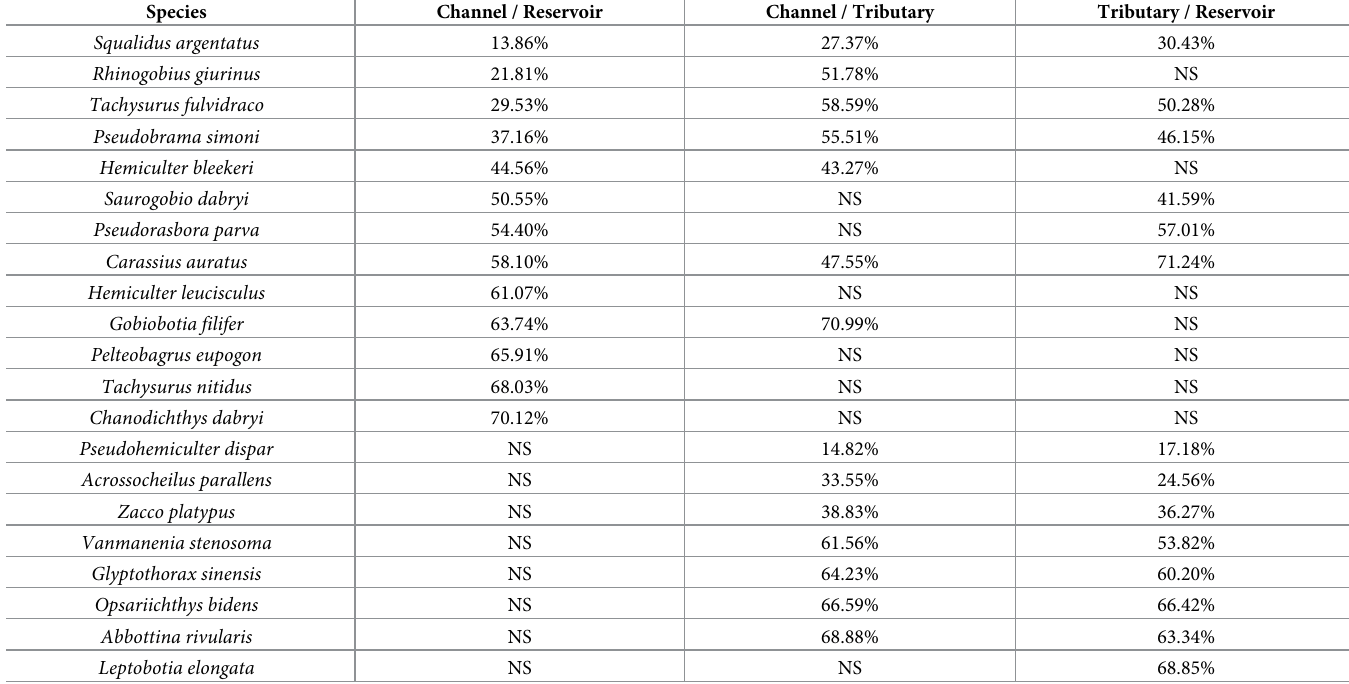
Table 2. Dissimilarity analysis (SIMPER) between fish assemblages in the middle and lower reaches of the Ganjiang River. The 21 species provided the greatest con- tribution and were shown for each site-pair comparison. NS: Community differences were not significant.